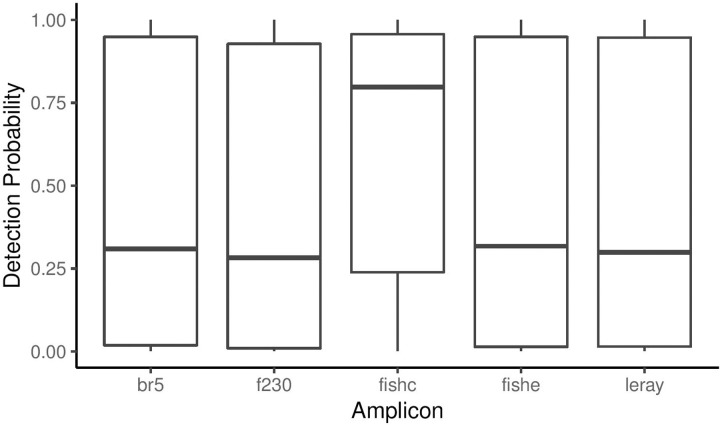
Mean detection probability estimated from occupancy model 9 (ψ(.) ϴ(.) p(amplicon)) for each species plotted by amplicon.The band in the middle of the box represents the median and the upper and lower edges of the box represent the upper and lower quartiles. The whiskers represent 1.5 times the inter-quartile range.